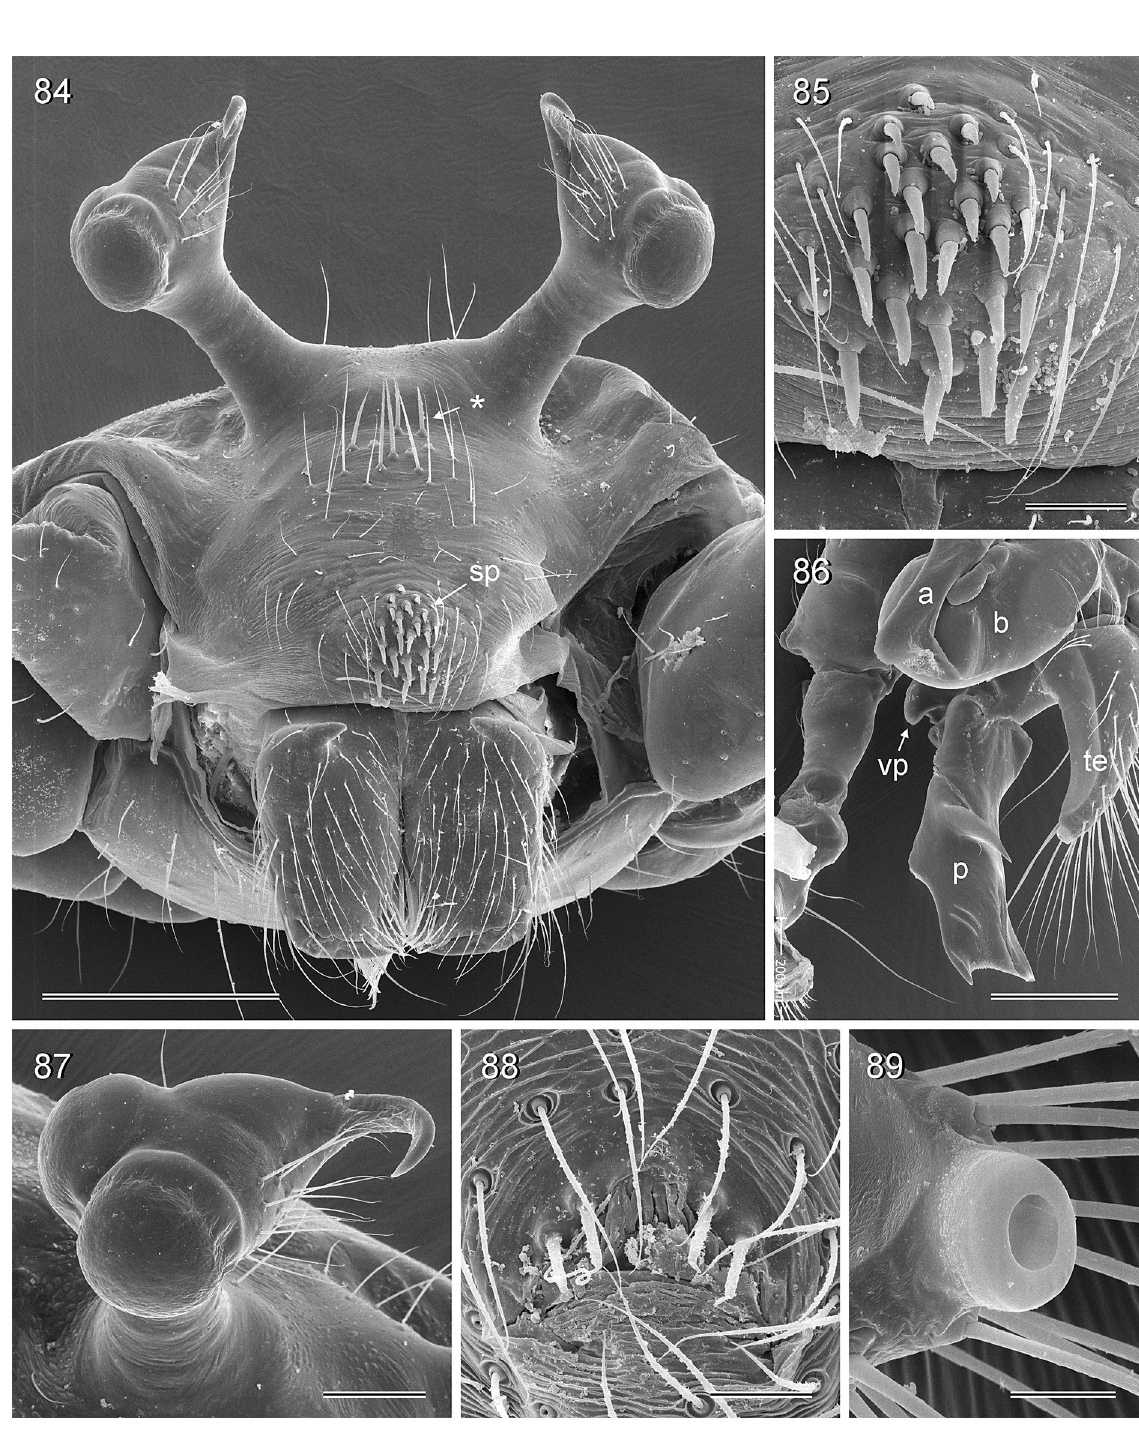
Figs 84–89. Panjange marilog Huber sp. nov., SEM micrographs (ZFMK, Ar 13019). 84 . Male prosoma, frontal view (asterisk marks stronger hairs below ocular area). 85 . Spines on male clypeus. 86 . Left male palp, prolateral view. 87 . Right eye stalk, triad, and hooked process, oblique frontal view. 88 . Male gonopore. 89 . Male palpal tarsal organ. Abbreviations: a = appendix; b = genital bulb; p = procursus; te = tarsal elongation; sp = spines on clypeus; vp = ventral process. Scale bars: 84 = 300 µm; 85 = 40 µm; 86 = 200 µm; 87 = 80 µm; 88 = 30 µm; 89 = 20